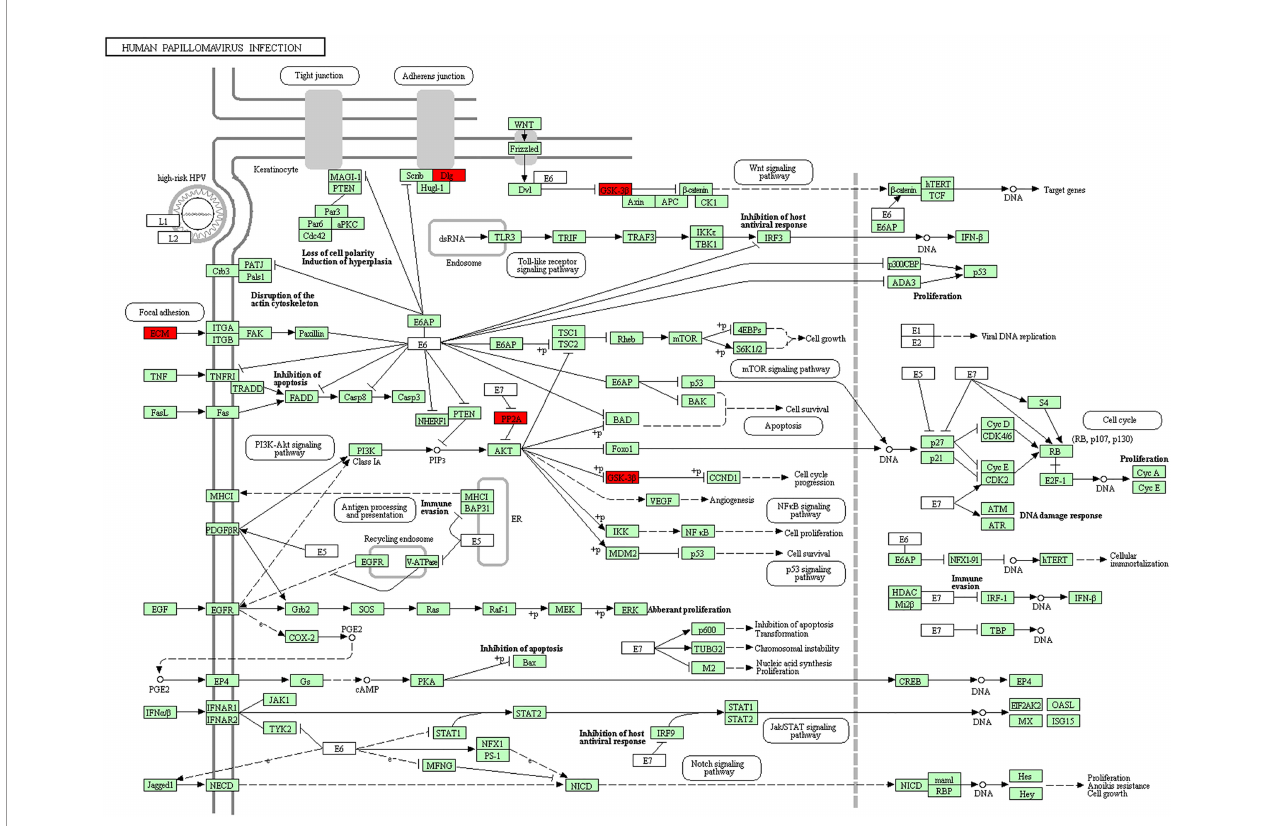
FIGURE 10 | Human papillomavirus infection signal pathway regulated by MAP mutations of NSCLC patients (DAVID). DAVID, Database for Annotation, Visualization, and Integrated Discovery; MAP, microtubule-associated protein; NSCLC, non-small cell lung cancer.